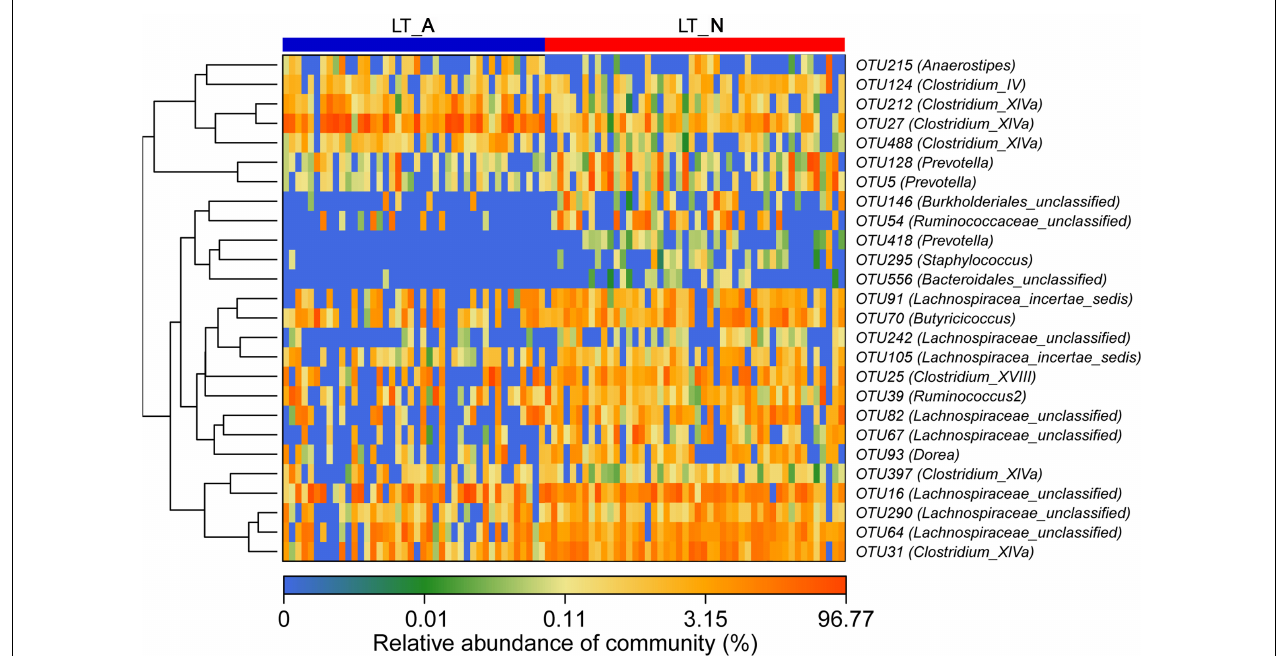
FIGURE 4 | Heat maps showing the relative abundance of the discriminatory OTUs that drive the differences between groups LT_A and LT_N. For each sample, the columns show the relative abundance data for the discriminatory OTUs listed to the right of the figure. The abundance values for each of the genera were clustered using unsupervised hierarchical clustering [the relative abundance of each genus is indicated by a gradient of color from blue (low abundance) to red (high abundance)]. The corresponding genus of each key OTU is noted to the right of the figure. The heat map on the left shows Spearman hierarchical clustering of relative abundance values for each of the 26 most discriminatory 97%-identity OTUs in a random forest-based model of the fecal microbiota of groups LT_A and LT_N. LT_A, fecal microbiomes of the liver recipients with abnormal liver function; LT_N, fecal microbiomes of the liver recipients with normal liver function; OTU, operational taxonomic